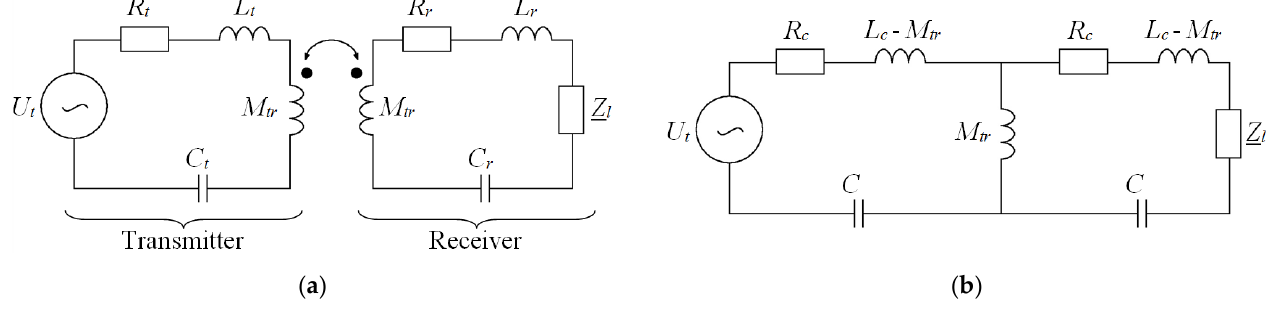
Figure 5. Circuit model of the cell in the WPT system: ( a ) model with indicated magnetic coupling, ( b ) two-port network model of the cell with identical Tx and Rx coils.